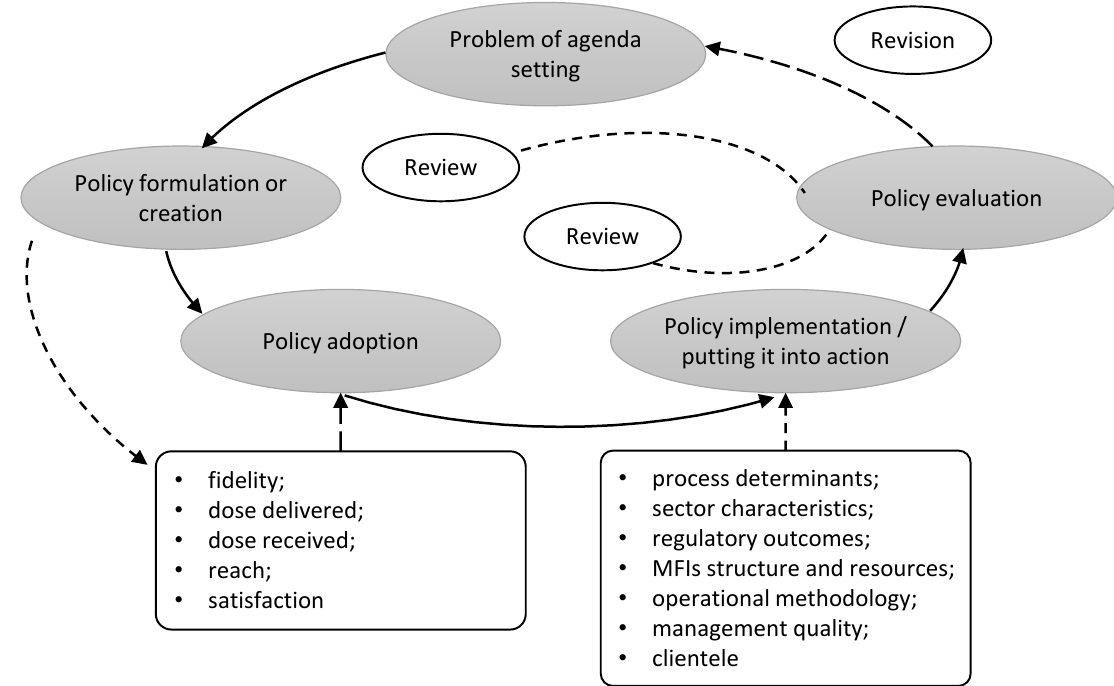
Figure 1. Policy implementation process